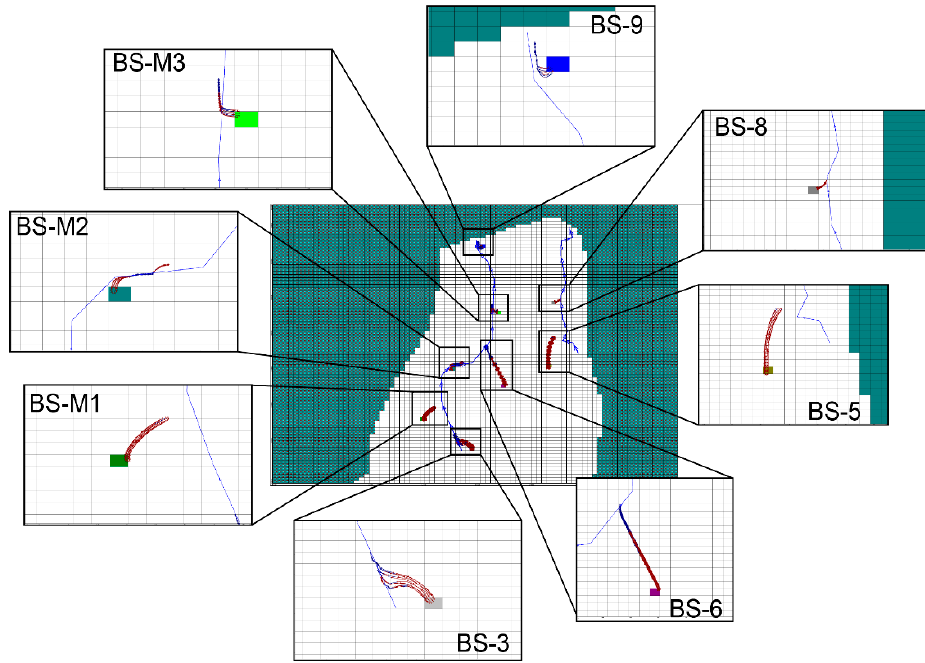
Figure 6. Forward particle tracking of the movement of particles from the wells.